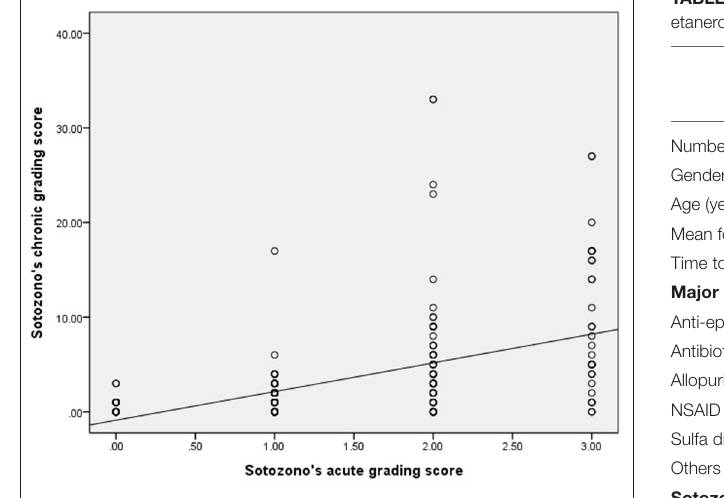
TABLE 4 | Comparison between corticosteroid with or without additional etanercept treatment on Sotozono’s acute and chronic stage grading